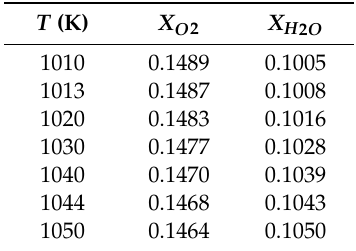
Table 3. Considered co-flow temperatures and compositions for lifted H 2 / N 2 jet flame [23] ( T : Temperature; X i : Mole